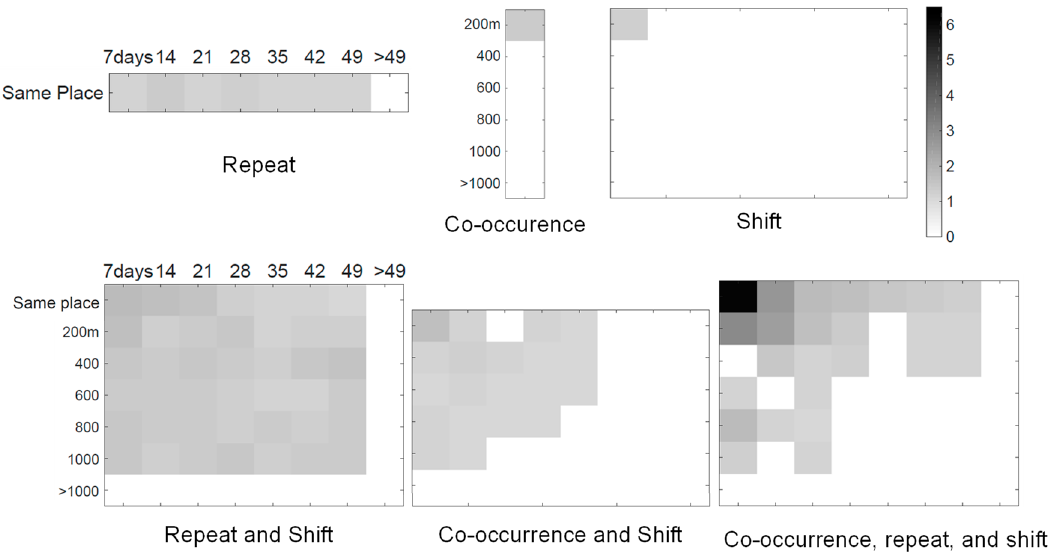
Figure 2. Crime risks introduced by different crime patterns.